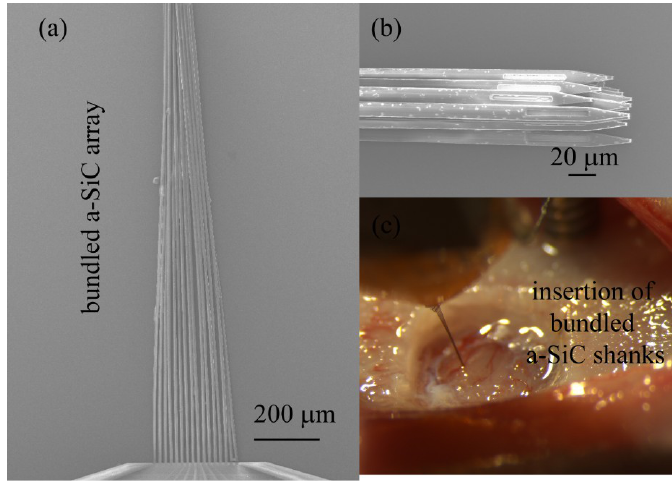
Figure 4. Bundles of 16-channel a-SiC MEA when drawn out of water ( a ) showing tip geometry ( b ). Insertion of a bundled 8-channel a-SiC array into rat cortex ( c